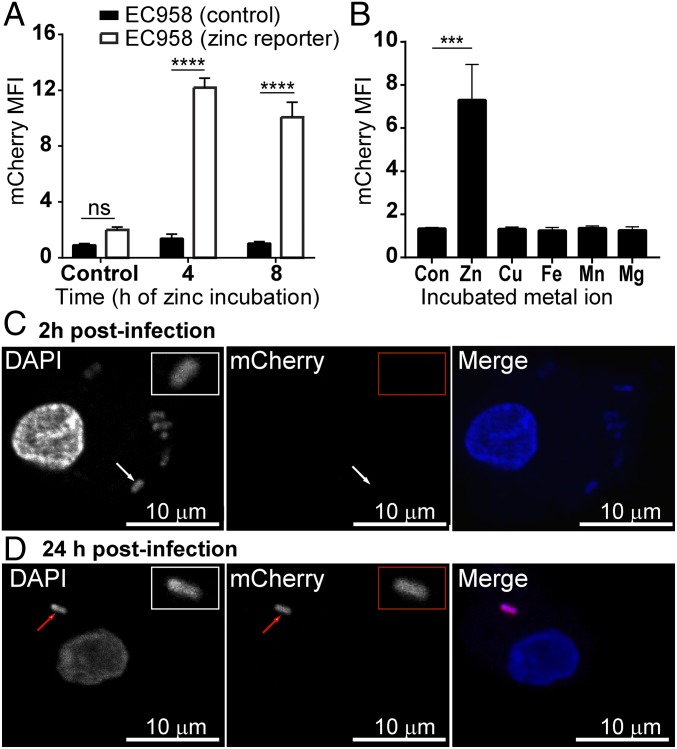
Development and validation of a UPEC EC958 zinc stress reporter strain. (A) Wild-type EC958 (filled bars) or the plasmid-encoded zinc stress reporter strain EC958 pQF50-zntA-mCherry (unfilled bars) were incubated in complete RPMI media (±500 µM ZnSO4) for 4 or 8 h, after which median mCherry fluorescence was determined by flow cytometry. Data (mean + SEM, n = 3) are combined from three experiments (****P < 0.0001, ns = not significant, two-way ANOVA with Sidak’s multiple comparisons test). (B) EC958-pQF50-zntA-mCherry was incubated in complete RPMI media supplemented with 500 µM of ZnSO4, CuSO4, FeSO4, MnCl2, or MgCl2 for 4 h, after which mCherry levels were assessed by flow cytometry. Data (mean + SEM, n = 3) are combined from three experiments (***P < 0.001, one-way ANOVA, with Dunnett’s multiple comparisons test). (C and D) HMDM were infected with EC958 pQF50-zntA-mCherry at an MOI of 100 for 1 h, followed by gentamicin exclusion. At 2 (C) or 24 (D) hpi, cells were fixed and stained with DAPI, and imaged for mCherry and DAPI fluorescence (white arrows: mCherry− bacteria; red arrows: mCherry+ bacteria). All images were captured using a Zeiss LSM 710 upright confocal microscope at 60× magnification. Images are from a single experiment, and are representative of three independent experiments.